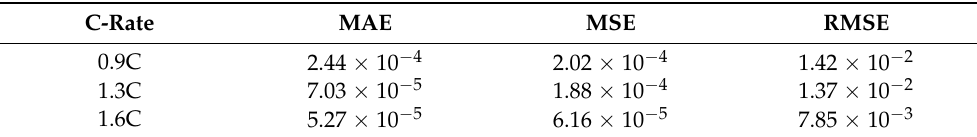
Table 6. RNN degradation model performance based on MAE, MSE, and RMSE values at various discharge rates: 0.9C, 1.3C, and 1.6C.